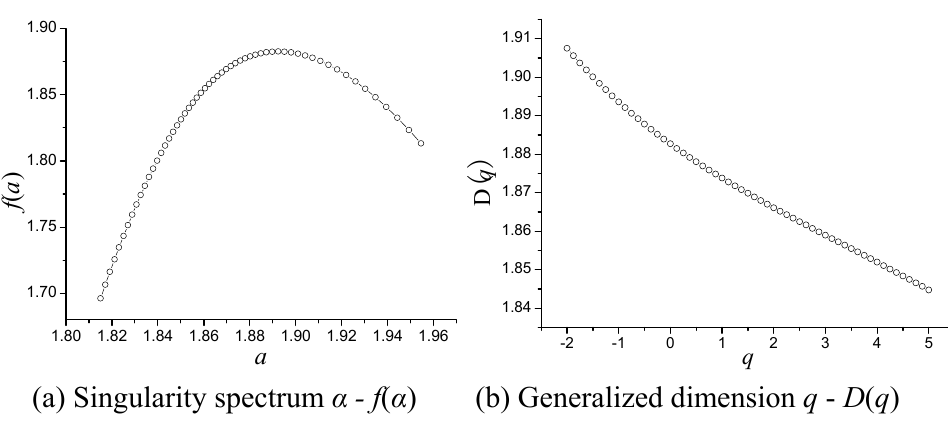
Figure 6. Multifractal spectrum of